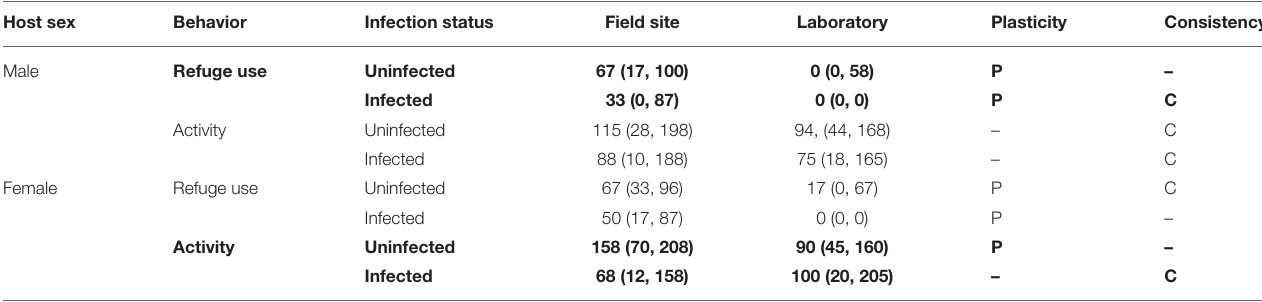
TABLE 4 | Estimates of plasticity and consistency for each behavior measured in two situations (immediately after collection at the field site, 24 h after collection in the laboratory).